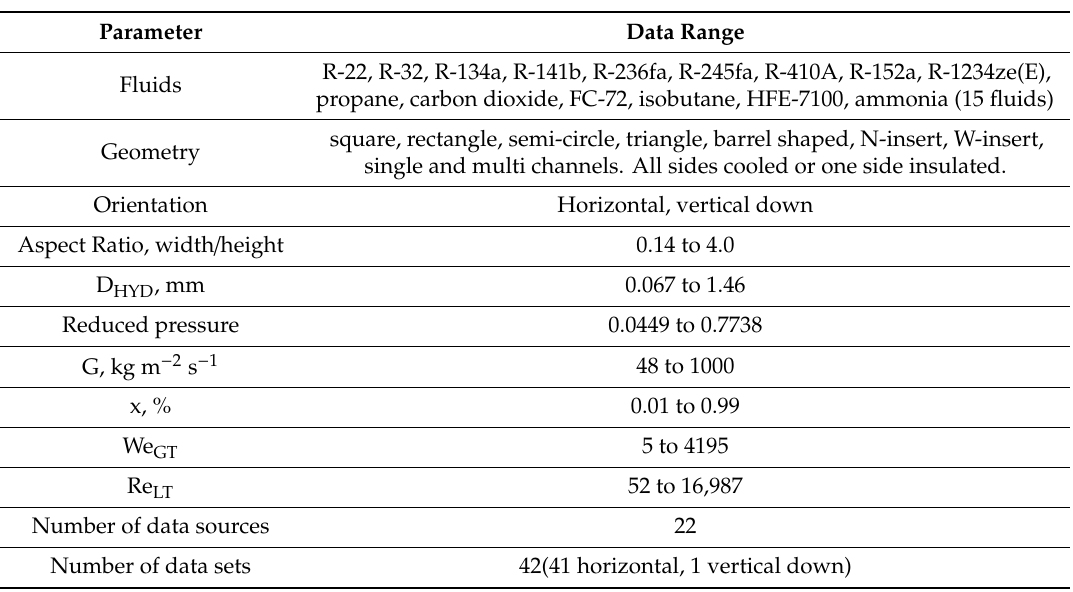
Table 1. Range of data for non-circular channels other than flattened